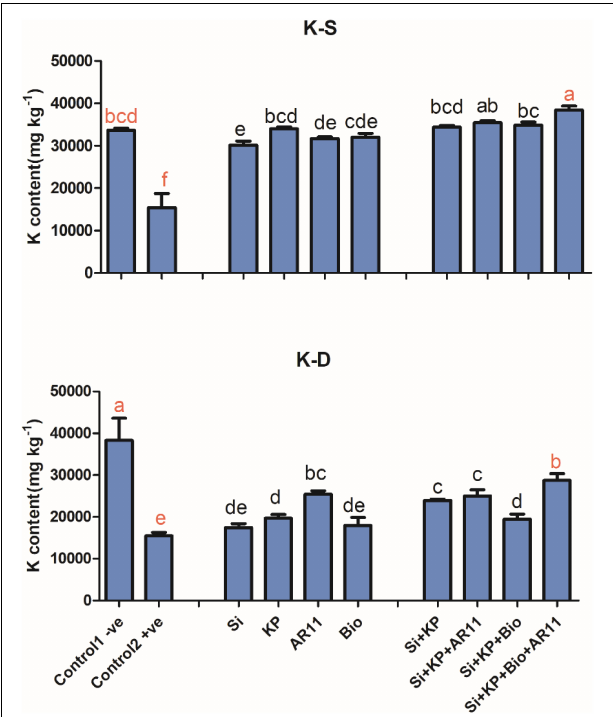
FIGURE 5 | Quantification of K + content in rice shoots subjected to salt and drought stresses following AR11, Si, K 2 HPO 4 , and biochar inoculation. (-S), salt; (-D), drought. Error bars represent standard deviations. Each data point represents the mean of at least three replications. Bars with different letters are significantly different from each other at P ≤ 0.05.